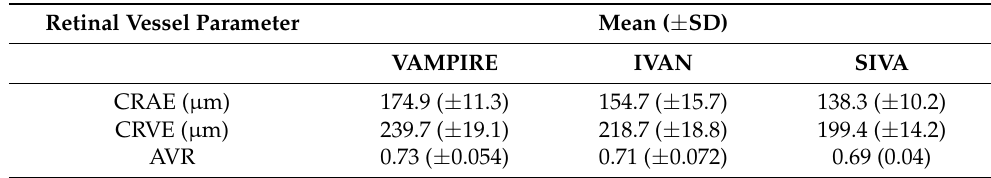
Table 2. Retinal vessel parameters with VAMPIRE, IVAN, and SIVA. CRAE: central retinal artery